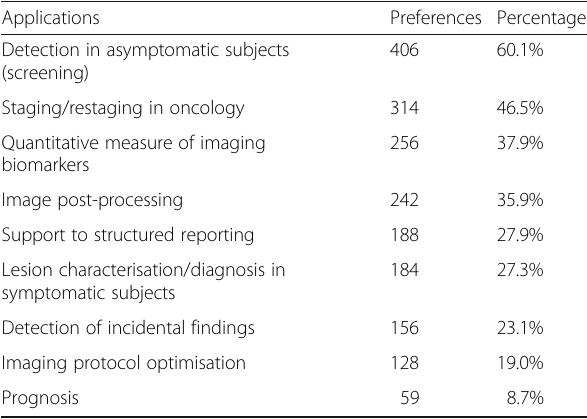
Table 4 Applications of artificial intelligence in radiology and their corresponding rates by 675